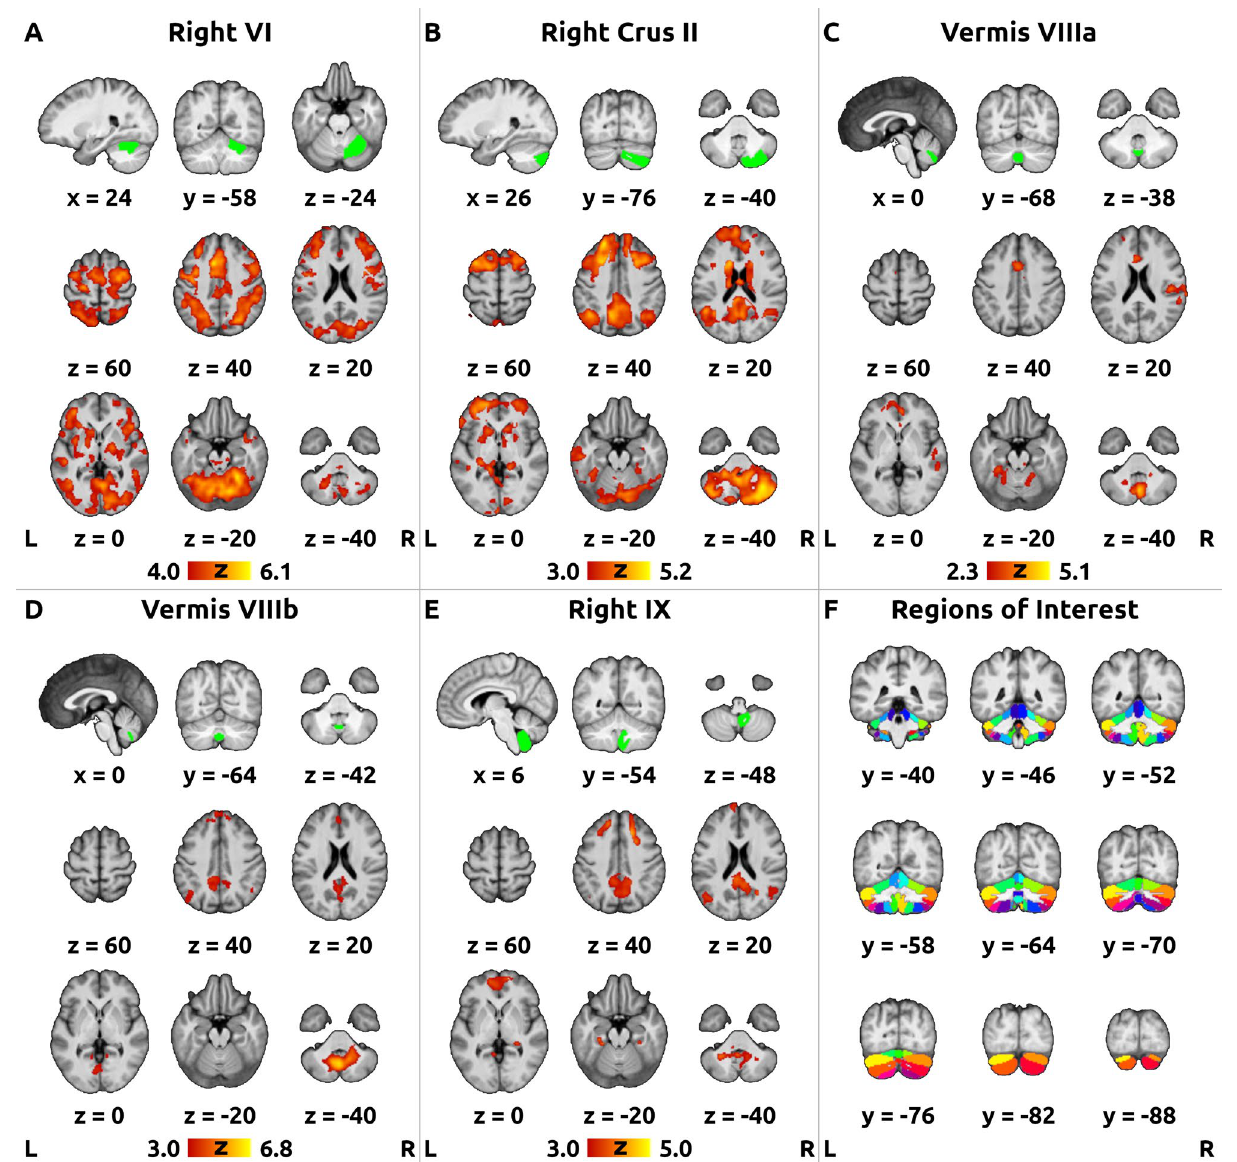
Figure 1. Mean functional connectivity of selected regions of interest. Figure shows mean post-hoc functional connectivity averaged across both sessions (baseline + follow-up) for the seeds with significant treatment-related changes and correlations in the main analysis: ( A ) Right Lobule VI, (b) Right Crus II, ( C ) Vermis VIIIa, ( D ) Vermis VIIIb, and ( E ) Right Lobule IX. The green overlays in the top row of panels A-E show the respective regions of interest (ROI) in the cerebellum. The red-yellow overlays in the bottom rows of panels A-E show the functional connectivity of each ROI across the whole brain, thresholded at different cluster-forming levels to produce visually comparable statistical maps (panel A: Z > 4.0; panels B, D,E: Z > 3.0; panel C: Z > 2.3) with the corrected cluster significance level of p < 0.05. An average T 1 -weighted image with the MNI152 standard space coordinates was used as a background. Right is right according to neurological